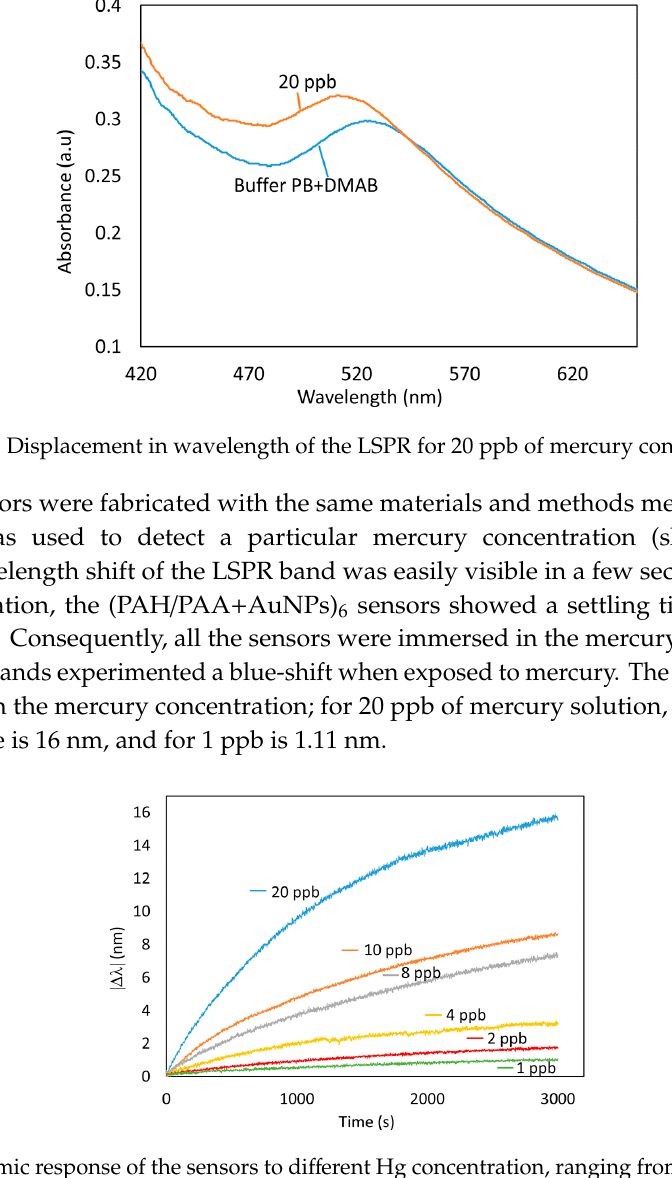
Figure 6. Maximum variation in wavelength ( Δλ max) for each mercury concentration (1, 2, 4, 8, 10, and 20 ppb) after 3000 s.